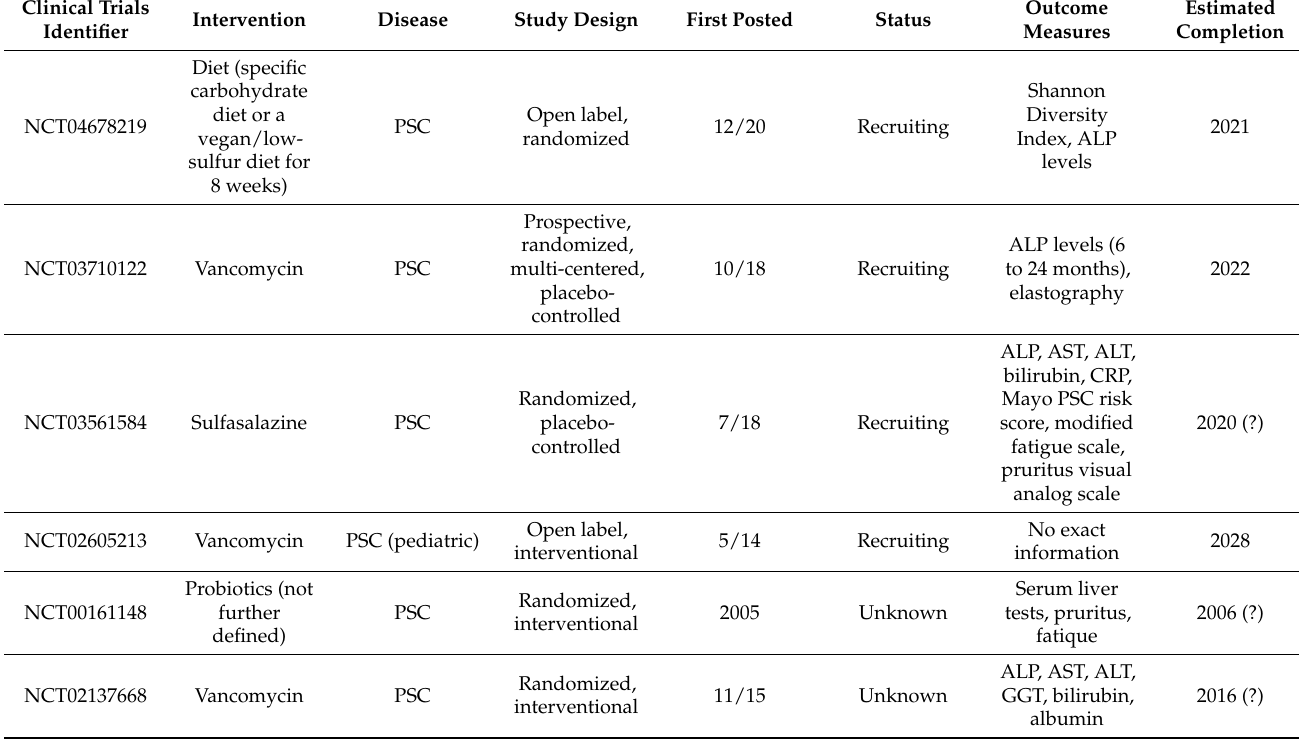
Table 3. Currently ongoing or future studies listed to modulate the gut microbiome in chronic cholestatic liver diseases. Source: clinicaltrails.gov. Search for: primary sclerosing cholangitis, sclerosing cholangitis, primary biliary cholangitis, primary biliary cirrhosis. Shown are studies labeled as recruiting, not yet recruiting, or with unknown status. Studies primary modulating bile acids are not mentioned. Date of access to the website clinicaltrials.gov: 1 February 2021. Clinical Trials